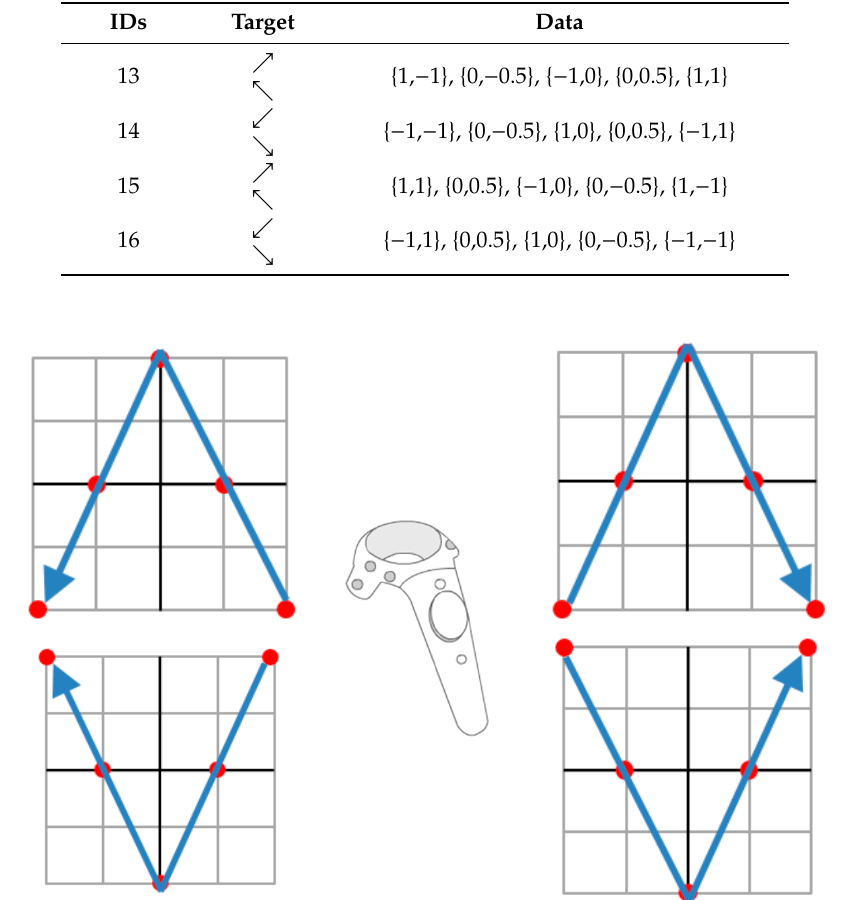
Table 3. Details of four recognition targets for horizontal V-shapes.